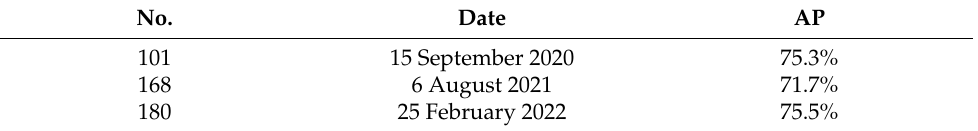
Table 10. The performance evolution of detectors on LS-SSDD-v1.0 (the data come from the 177 papers). No.